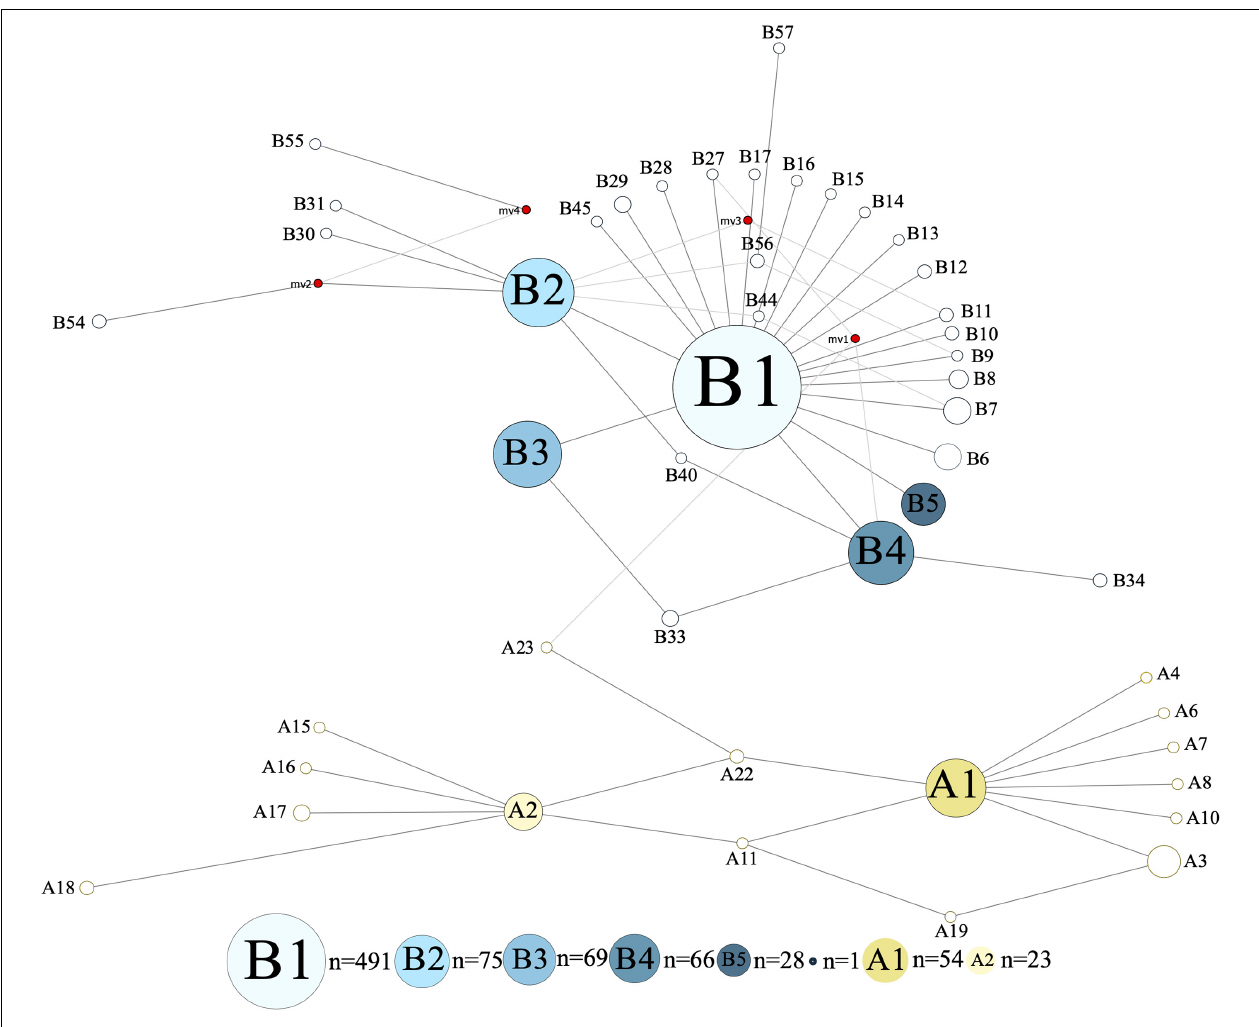
FIGURE 3 | Median Joining Network of 867 bp camel mtDNA sequences. Singletons were excluded resulting in 47 haplotypes. Red circles represent median vectors. Colors are based on haplotype identity and